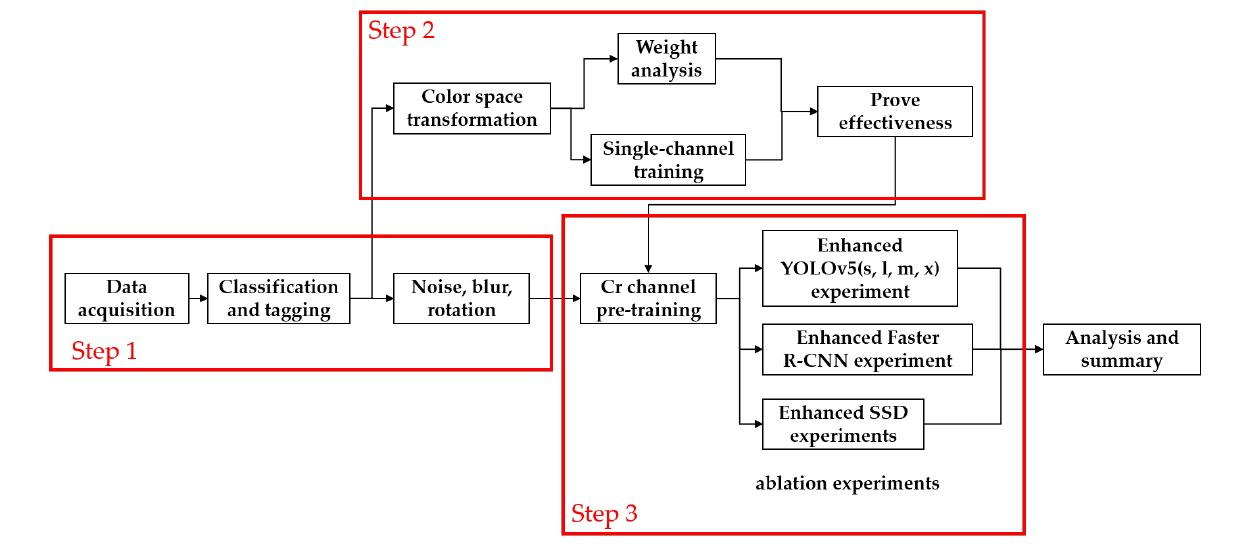
Figure 5. A brief flow chart of the experiment: Step 1: Obtain the images and construct dataset. Step 2: Analyze the weight of each channel to choose the channel with the highest weight. Step 3: